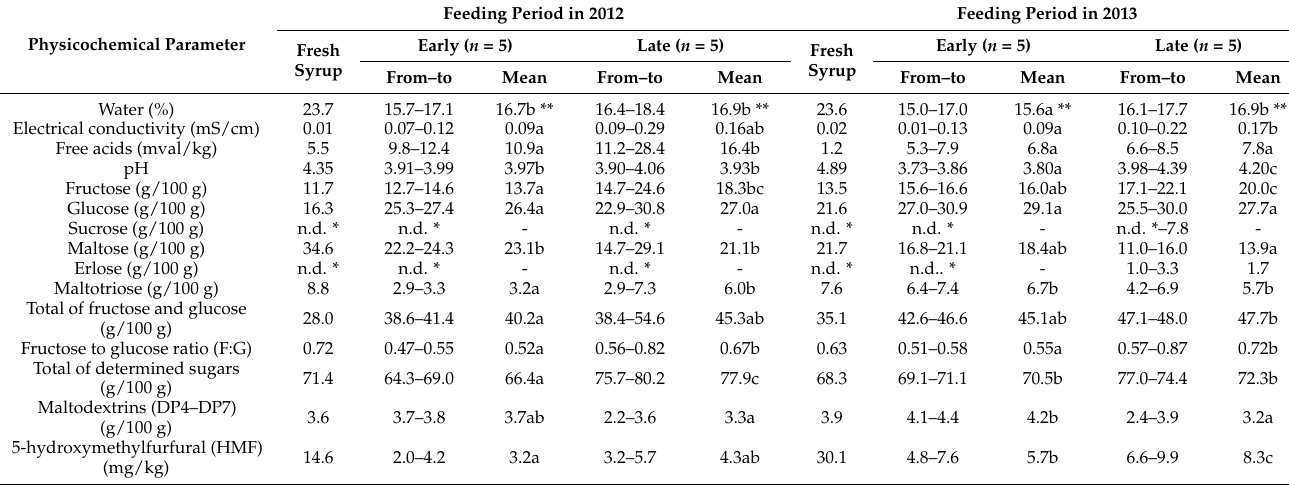
Table 2. Physicochemical composition of winter stores produced by bees fed with starch syrup II (Apikel 20).